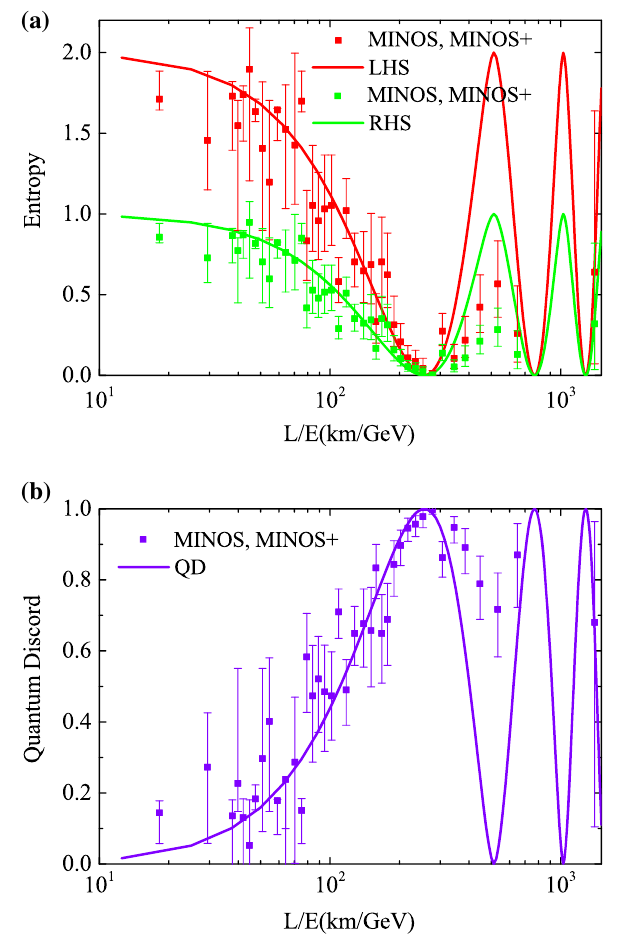
Fig. 2 a The entropic uncertainty and the uncertainty’s lower bound in Eq. (7) in theory (solid line) and experiment (square) with the error bars in regard to the distance traveled per energy L / E for the initial μ -flavor state; b The quantum discord quantified by Eq. (9) in theory and experiment with the error bars in regard to L / E for the initial μ -flavor state. LHS (solid line, red) denotes the entropic uncertainty [the left-hand side of Eq. (7)]; RHS (solid line, green) represents the uncertainty’s lower bound [the right-hand side of Eq. (7)]; QD (solid line, violet) corresponds to the quantum discord